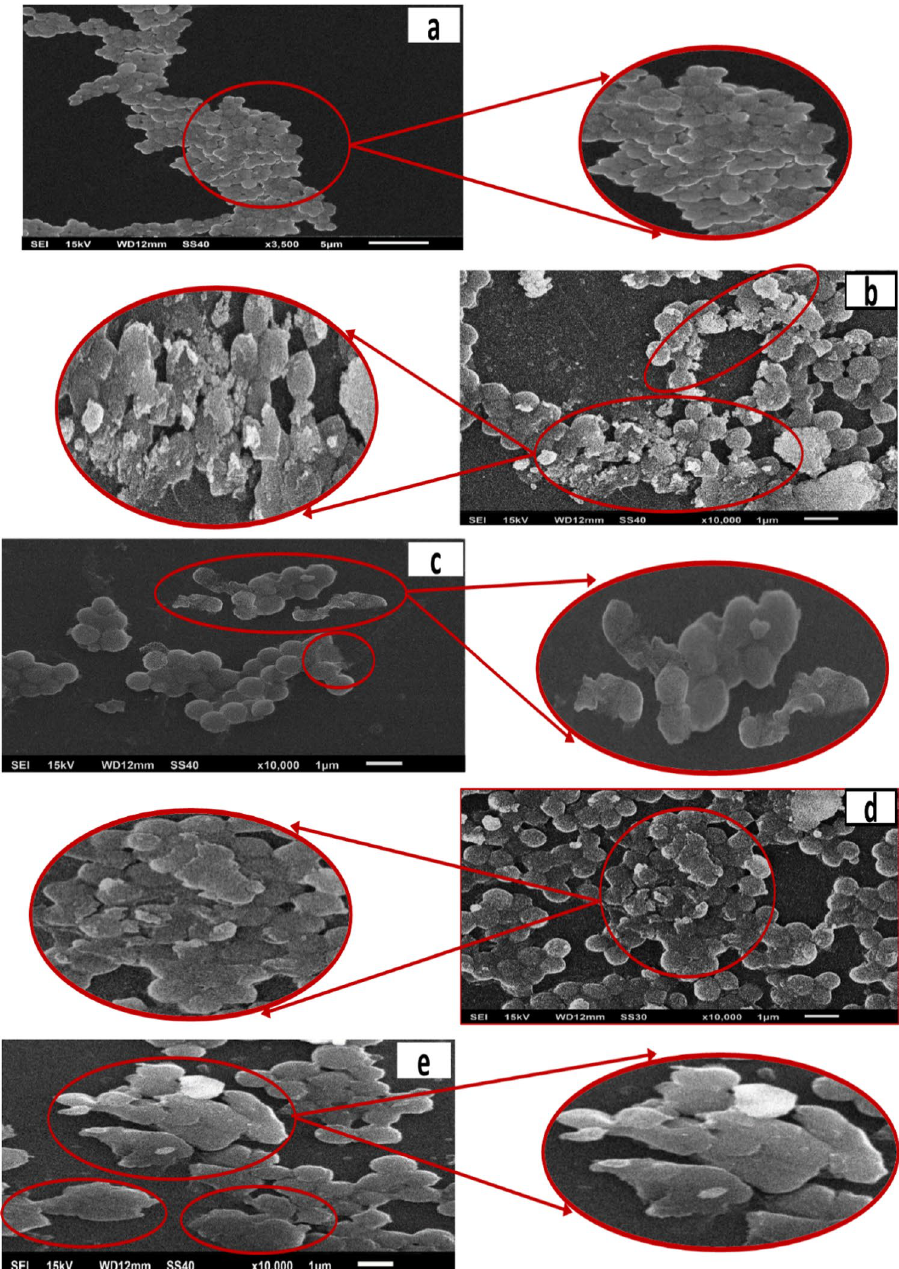
Figure 23. Scanning electron microscopy (SEM) images of S. aureus cells. ( a ) Untreated, ( b ) treated with 5% of Ni-doped MgO nanoparticles, ( c ) treated with 5% of Co-doped MgO nanoparticles, and ( d ) treated with 5% of Fe-doped MgO nanoparticles. Red circles indicate membrane regions of S. aureus damaged by